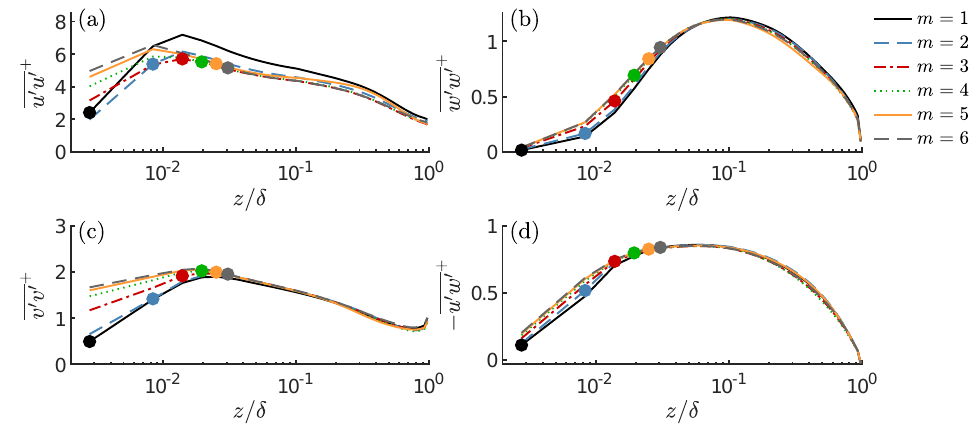
+ + + + , ( b ) w (cid:48) w (cid:48) , ( c ) v (cid:48) v (cid:48) and ( d ) u (cid:48) w (cid:48) as function